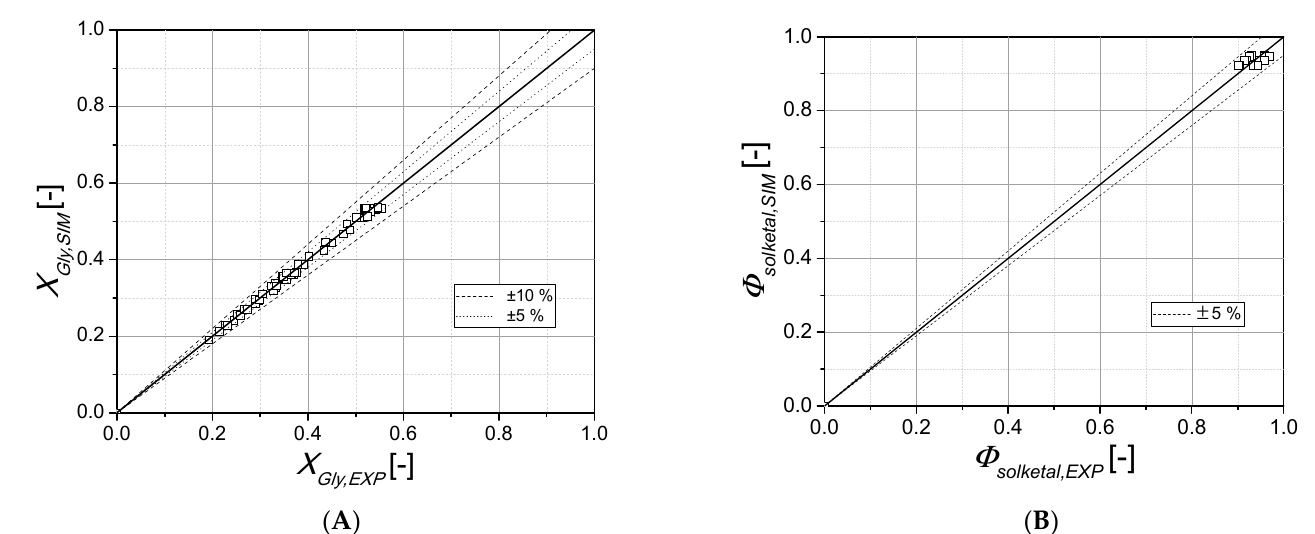
Figure 6. Parity plot for all the experimental data. ( A ) Glycerol conversion. ( B ) Solketal selectivity.